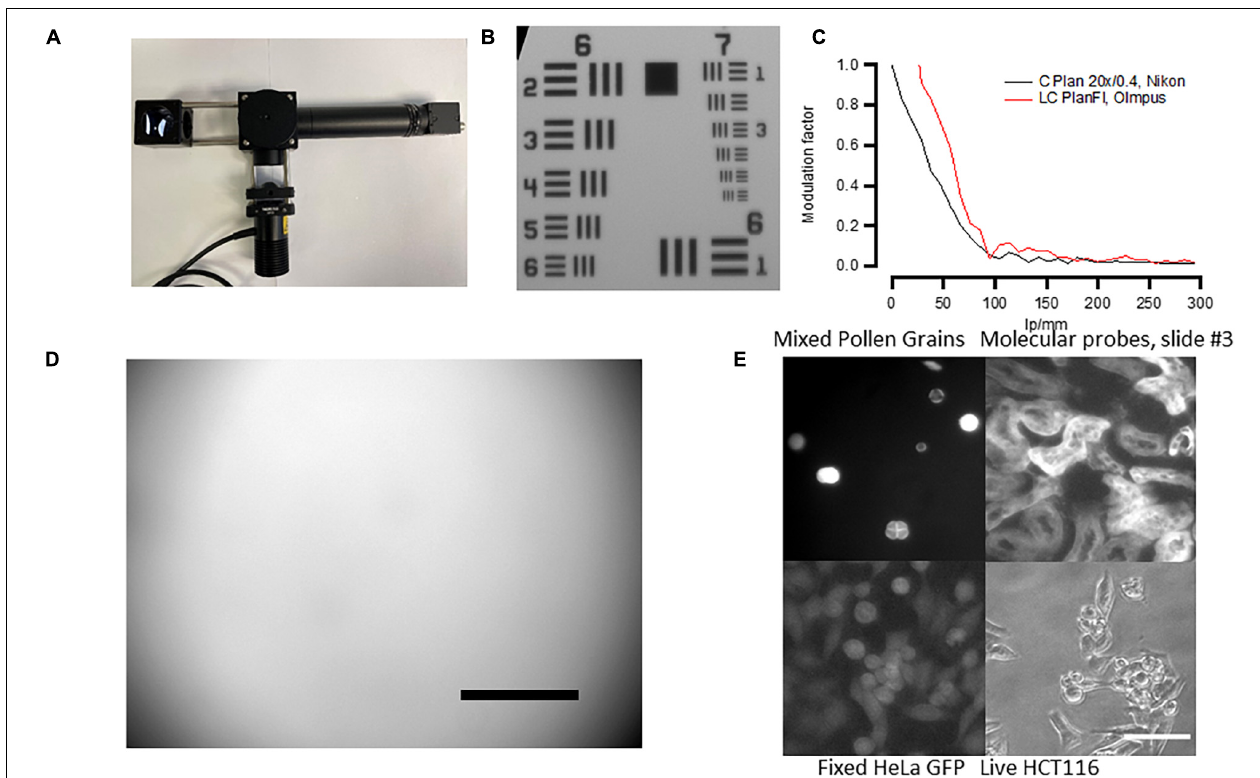
FIGURE 4 | Fluorescent microscope’s performance. (A) Assembled microscope and the autofocusing system. See Supplementary Material for the building instructions. (B) Micrograph of the USAF 1951 standard. The microscope can resolve Group 7/Element 6 features (2.19 µ m size). (C) Modulation transfer function calculated from USAF 1951 standard using Fiji SE_MTF plugin (Mitija et al., 2011) Black trace—cheap Nikon Plan 20 × non-infinity-corrected objective. Red trace—more expensive Olympus infinity-corrected microscope (see Supplementary Table 2 for more information). (D) Micrograph of green Chroma slides showing mild vignetting. Scale bar, 100 µ m. Note that the scale bar only provides an approximate value because non-infinity-corrected objective was used. (E) Example of the autofocusing system performance in both white transillumination and fluorescence. Scale bar, 30 µ